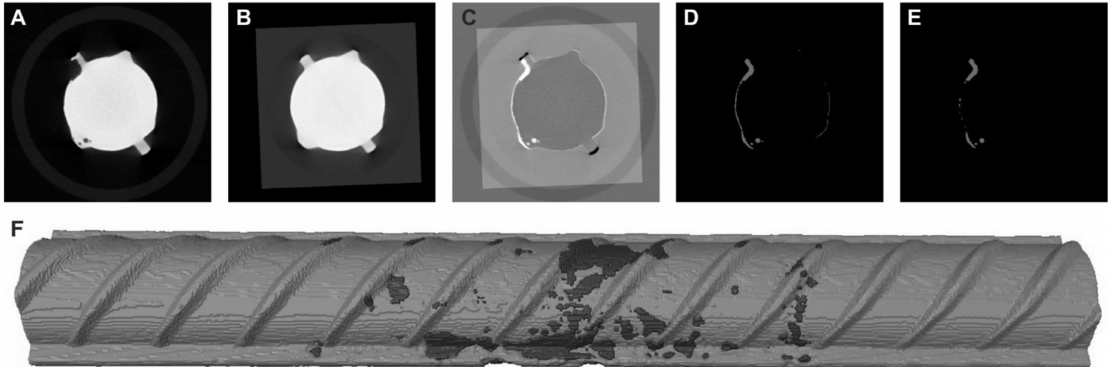
Figure 5. An overview of the image processing with ( A ) the reconstructed corroded image, ( B ) the reference image, ( C ) the differential image originating from subtracting the corroded image from the reference image, ( D ) the segmented image in which the bright grey values of C were withheld, and ( E ) the segmented image after an ‘opening’ operation. ( F ) The segmented dataset (from ( E ), dark grey) is rendered together with the original corroded dataset (from ( A ), light grey). The rebar diameter amounts to 10